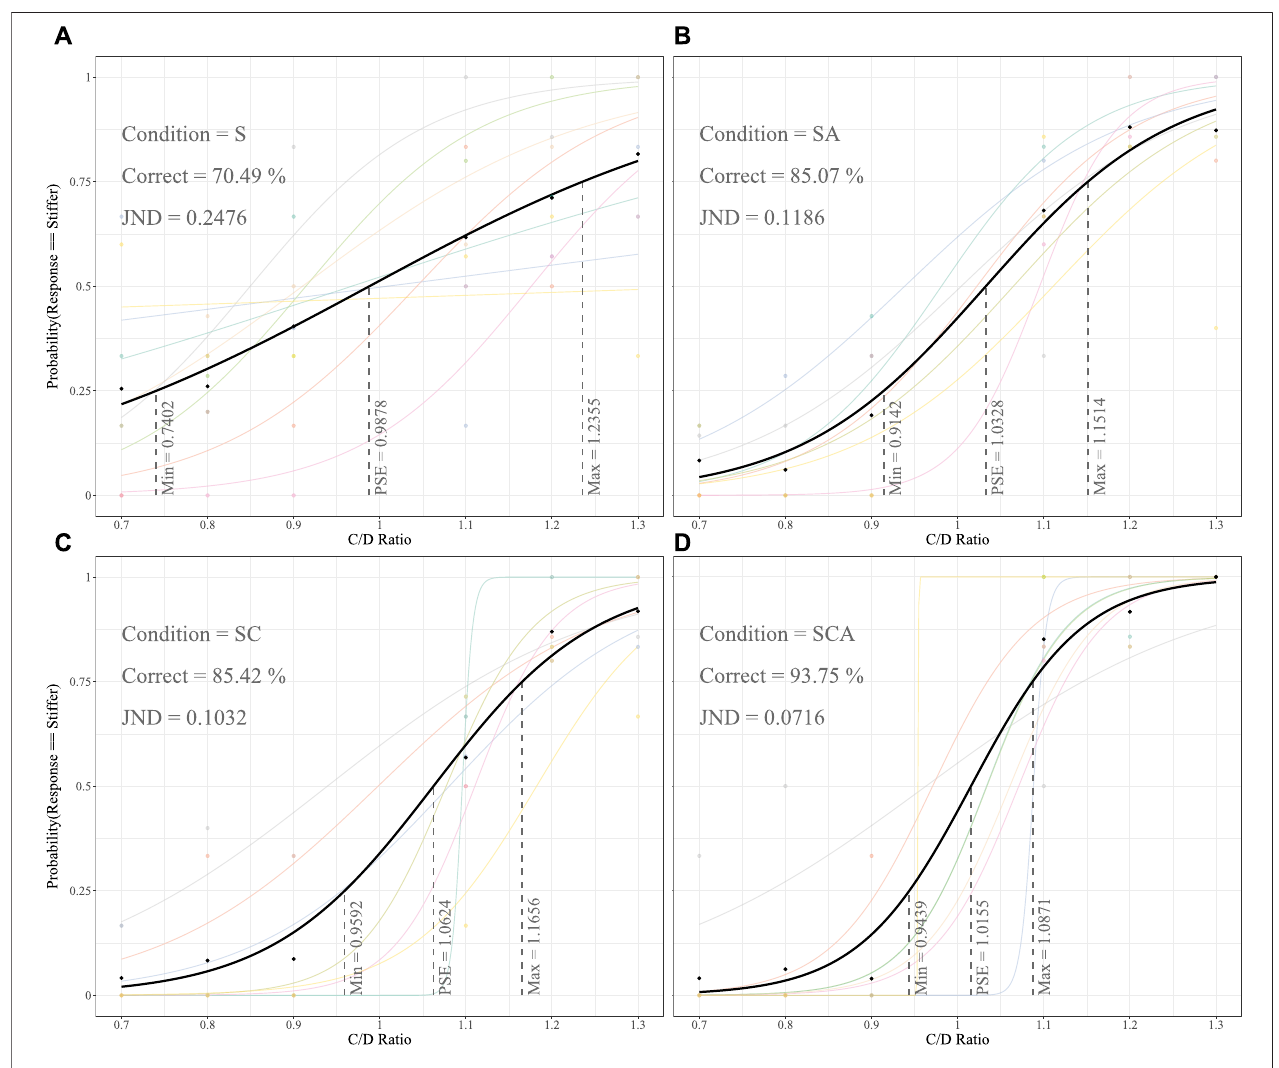
FIGURE 6 | C/D ratio vs. stiffer responses for the tested conditions (see Table 2 ): (A) stiffness only , (B) stiffness + activation , (C) stiffness + contact , and (D) stiffness + contact + activation .